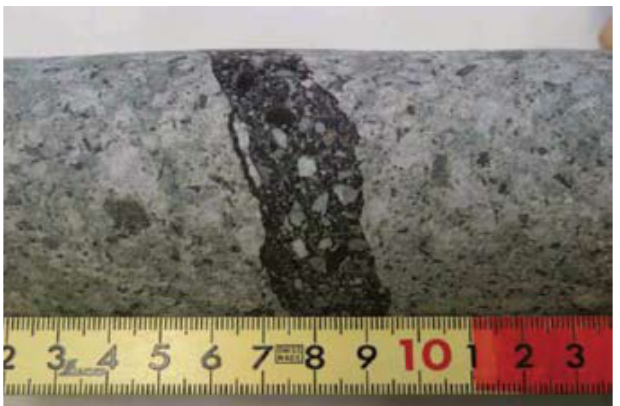
Figure 5. Photograph showing a core sample including pyroclastic vein. As the core was recovered from the hole inclined about 75˚, the contacts of the vein were nearly vertical. Black-colored clasts in the vein are quenched blobs of molten magma that were originally glassy.